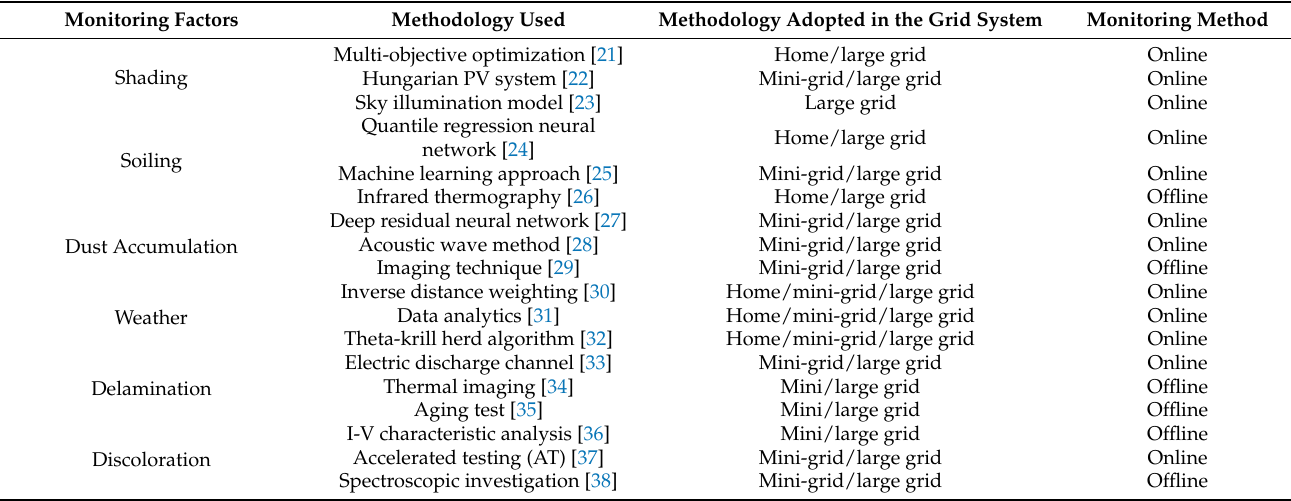
Table 1. Comparison of methodologies used for predominant defects in PV